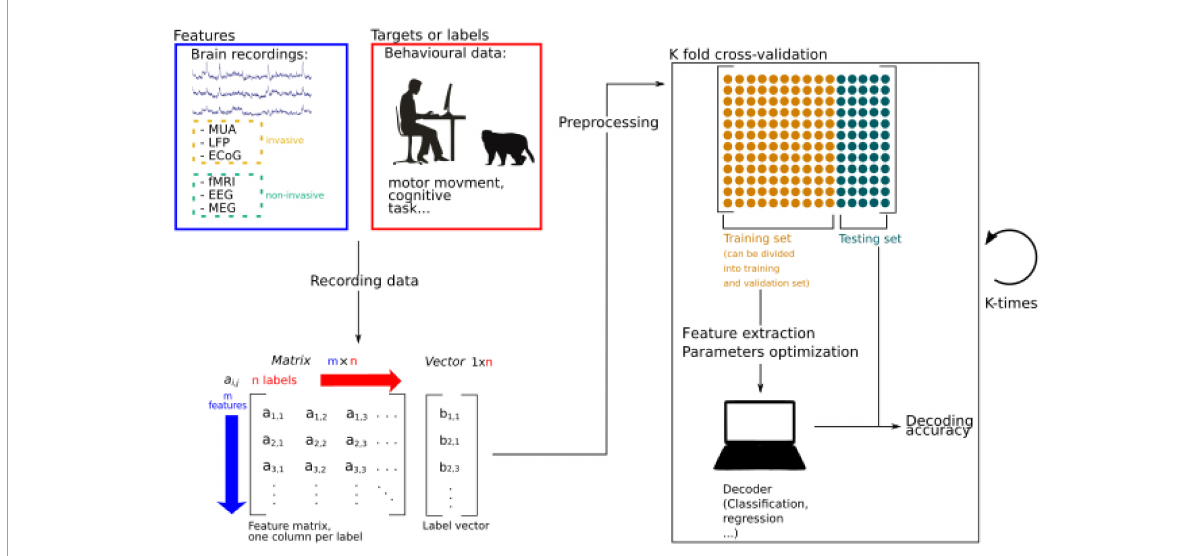
FIGURE1 Schematic representation of machine learning procedures applied to brain decoding. Brain activity is recorded while participants are performing a specific behavioral task. The recorded data is stored as a matrix and data is pre-processed to extract relevant information and increase the signal to noise ratio. Extracted information is called features. Then the data is split into two sets, a training, and a testing set. The training set can further be divided into a training set and a validation set, used to perform feature extraction and parameters optimizations. If the algorithm is supervised, features and labels are fed to the decoder. In unsupervised learning, only the features are used to train the algorithm. The performance of the decoder is then estimated by testing its accuracy thanks to the remaining testing set. Splitting the data into training and testing sets can be done by splitting the data into N sets ( N is a number to be defined) allowing to generalize the performance of the algorithm by calculating an average decoding